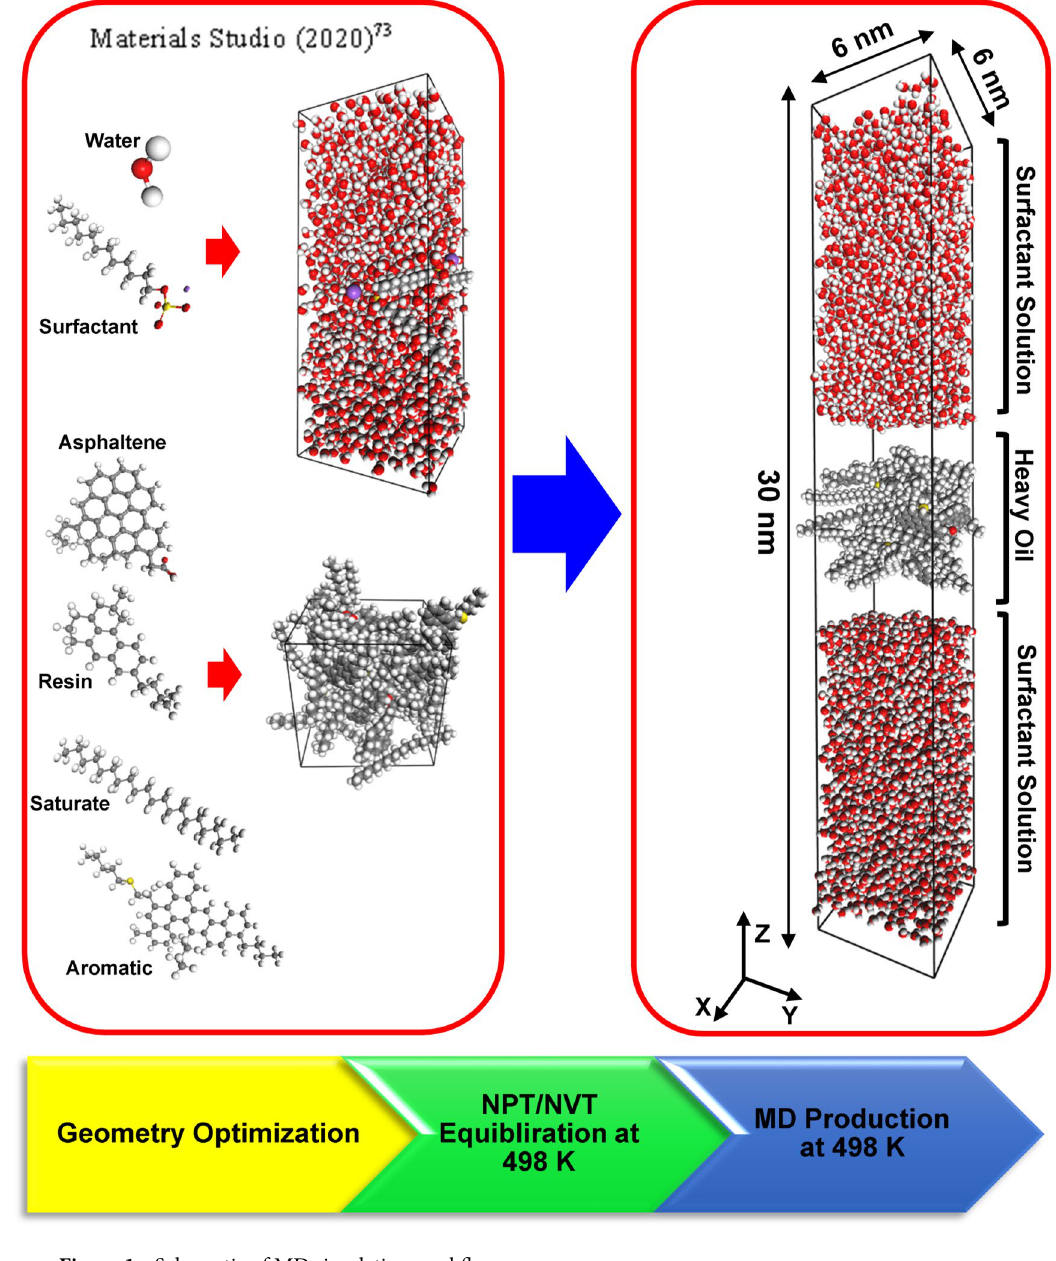
Figure 1. Schematic of MD simulation